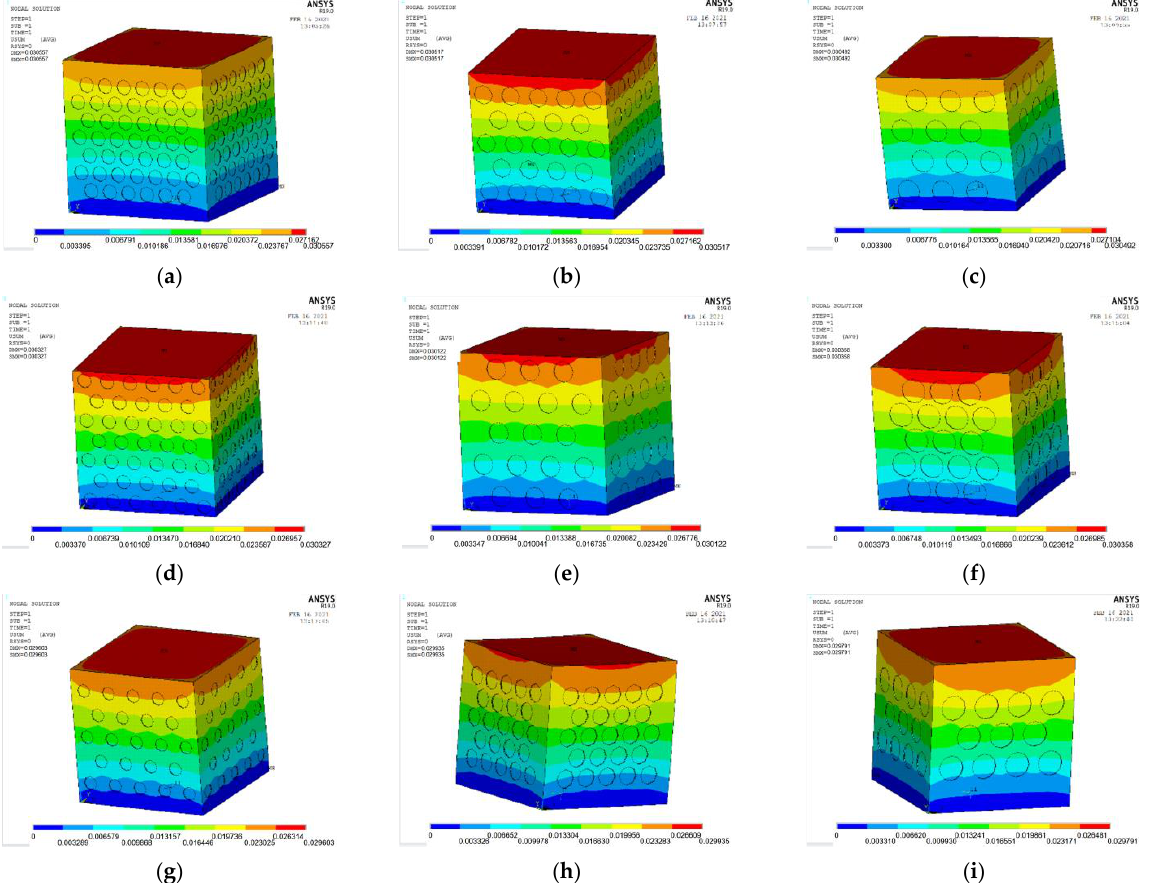
Figure 14. Strain cloud images of nine groups of compression perforated steel plate reinforced concrete samples: ( a ) test number 1; ( b ) test number 4; ( c ) test number 7; ( d ) test number 2; ( e ) test number 5; (f) test number 8; (g) test number 3; (h) test number 6; (i) test number 9.